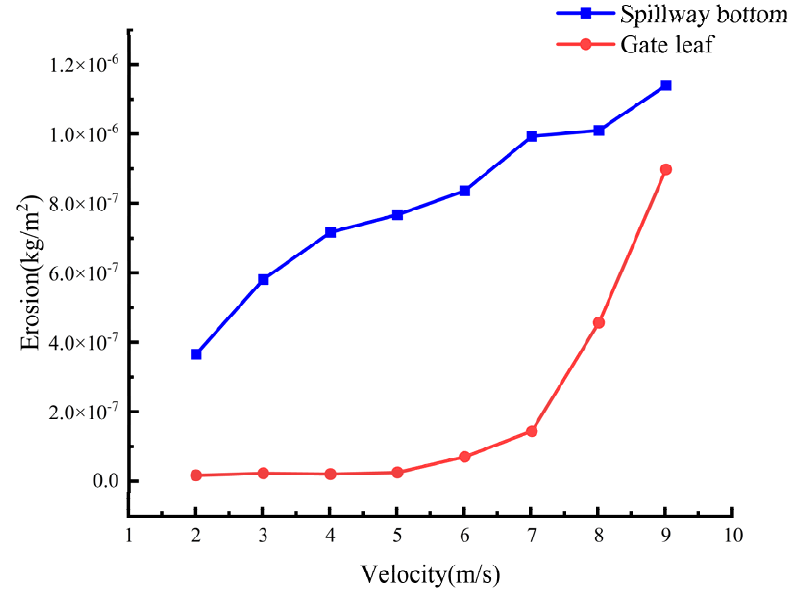
Figure 12. Relationship between erosion amount and inlet velocity of flow